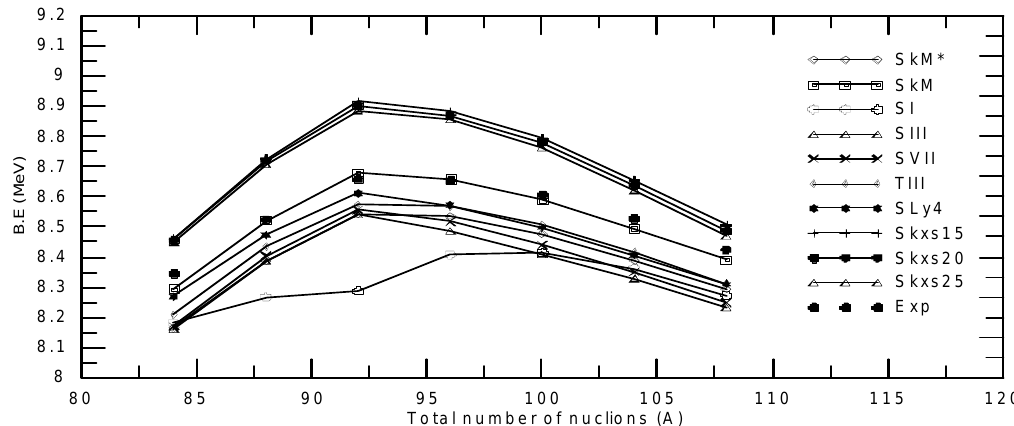
Fig.3: The total binding energy per nucleon for 84-108 Mo isotopes using different Skyrme parameterizations within HF method.